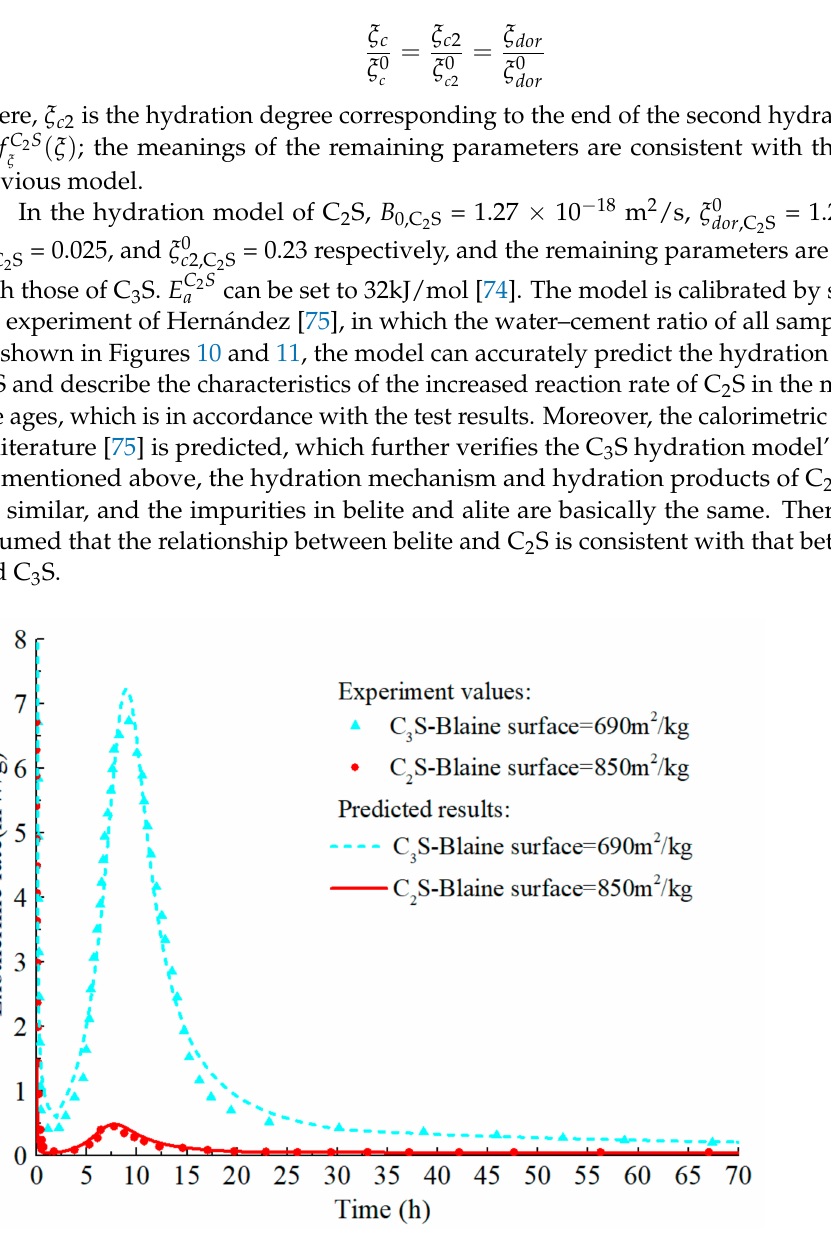
Figure 10. Isothermal calorimetry test values and prediction curves for early hydration of C 2 S and C 3